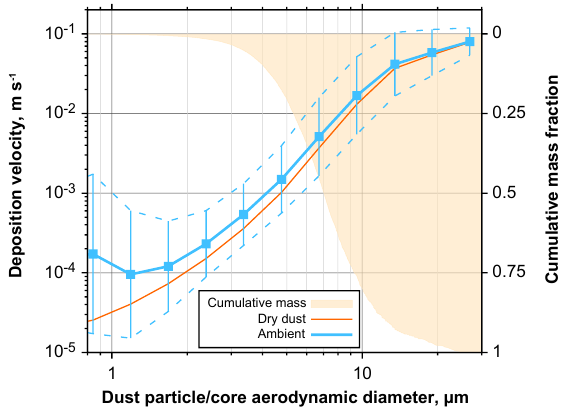
Figure 18. Effective deposition velocity for all dust-containing par- ticles observed at Ragged Point. The blue curves take into ac- count internal mixing and hygroscopic growth at ambient condi- tions, whereas the orange only regards the dry dust fraction of the particles. In addition, cumulative mass distribution is shown on the inverted right axis. Particle size is given as aerodynamic diameter for the dust fraction of a particle. For the ambient deposition veloc- ity, the geometric mean for each size class is shown in conjunction with the 1 geometric standard deviation